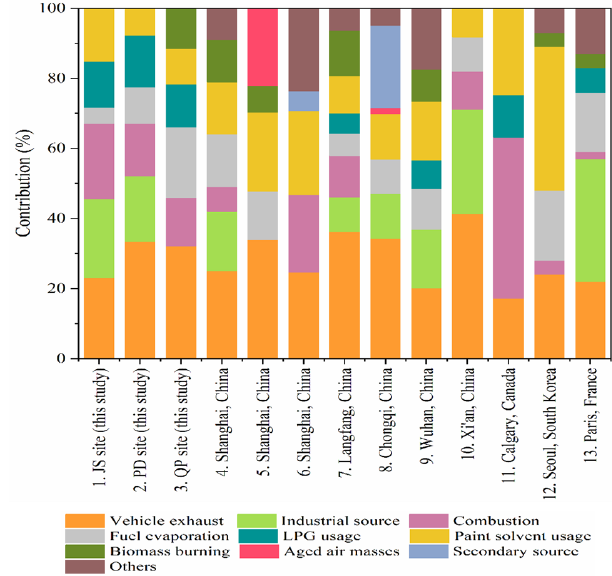
Figure 10. Primary emissions of the observed atmospheric VOCs of this study and those measured at different locations or during dif- ferent periods: (1, 2, 3) Shanghai, China (this study); (4) Shanghai, China (Cai et al., 2010a); (5) Shanghai, China (Liu et al., 2019); (6) Shanghai, China (Liu et al., 2021); (7) Langfang, China (Song et al., 2019a); (8) Chongqing, China (Li et al., 2018); (9) Wuhan, China (Hui et al., 2018); (10) Xi’an, China (Song et al., 2021); (11) Calgary, Canada (Bari and Kindzierski, 2018); (12) Seoul, South Korea (Song et al., 2019b); (13) Paris, France (Gaimoz et al.,